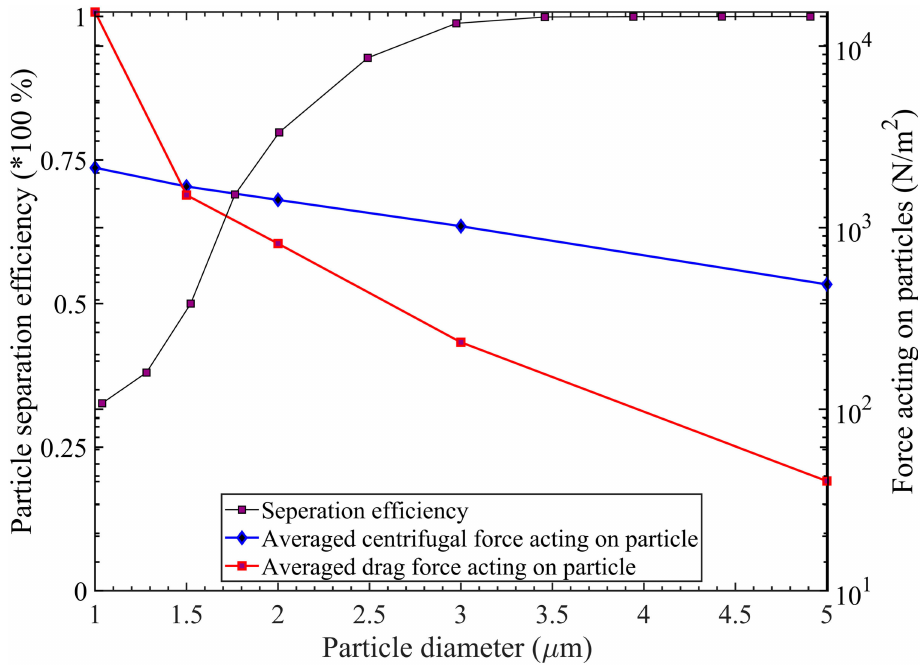
Figure 8. The averaged force results acting during the separation time with the separation e ffi ciency